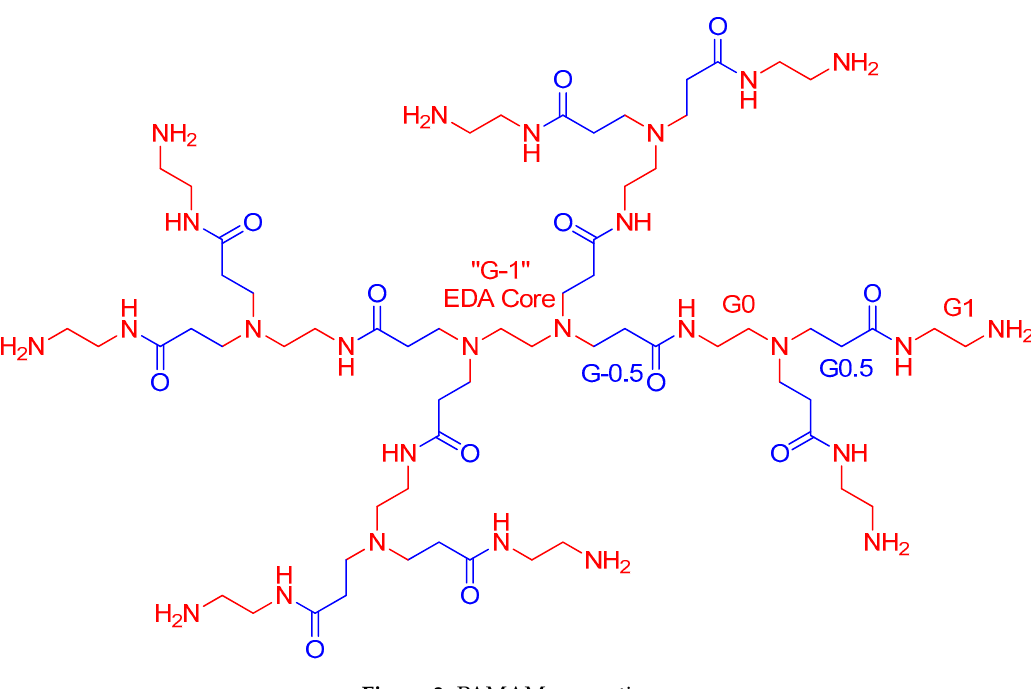
Figure 3. PAMAM generations.